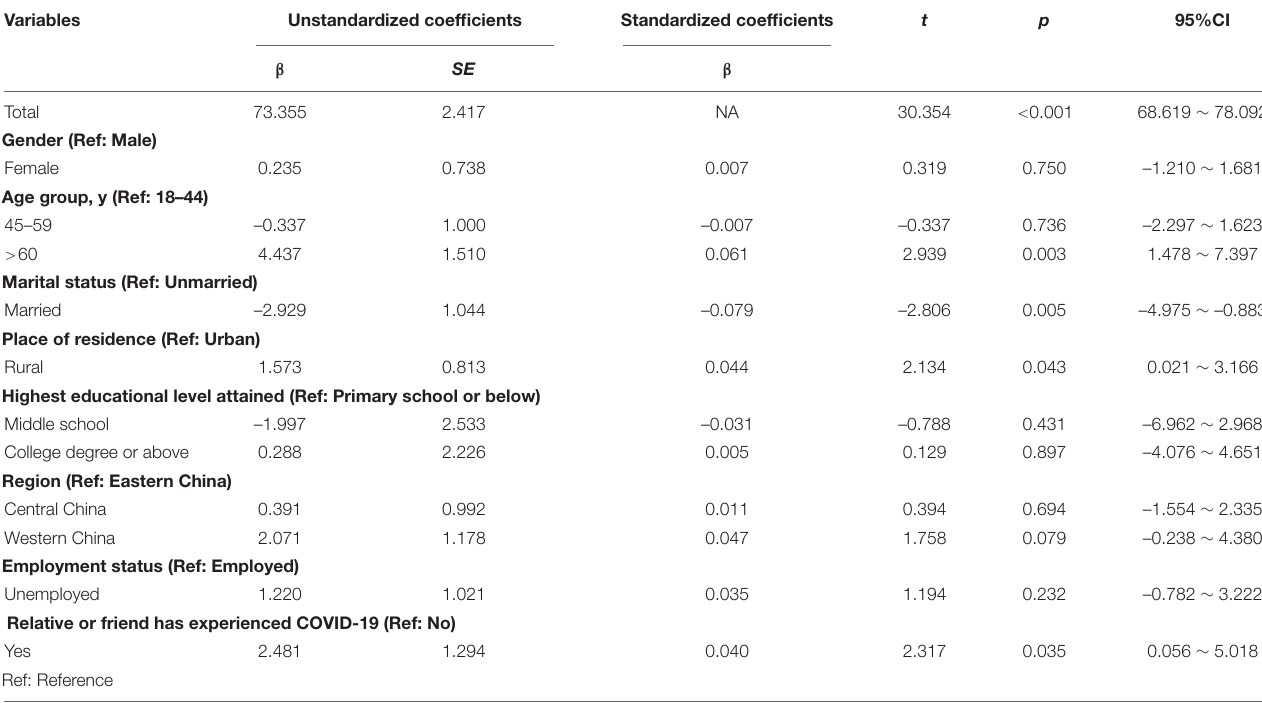
TABLE 3 | Regression analysis of associated factors for SAS Scores among